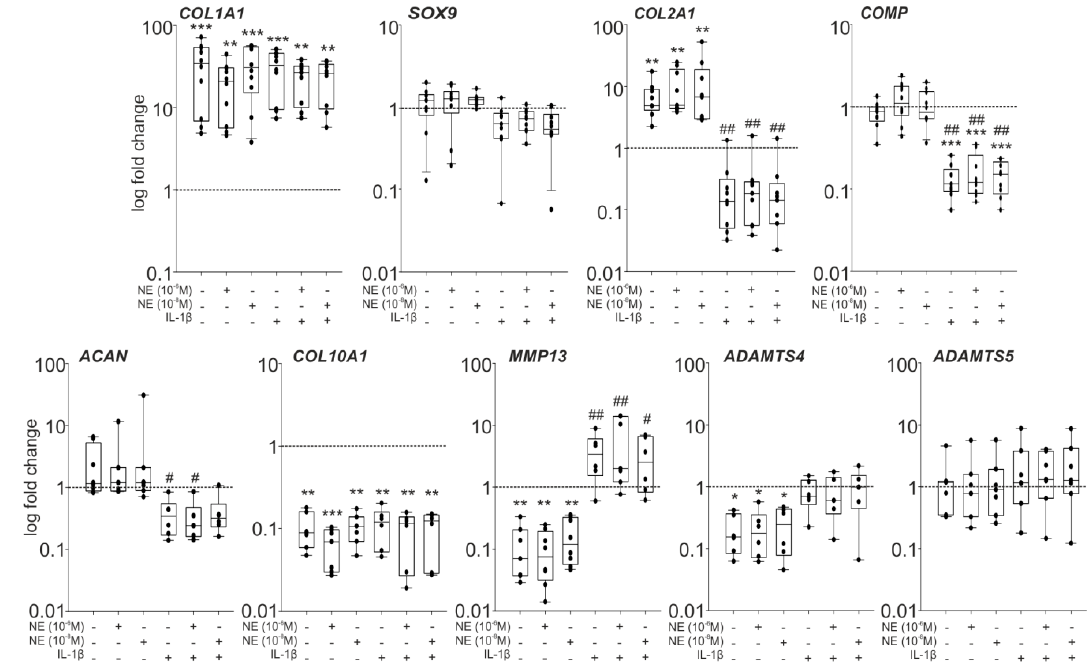
Figure 5. Effects of NE and IL-1 β on OA chondrocyte gene expression. Gene expression changes of the transcription factor SOX9, ECM components, and ECM-degrading enzymes after seven days in monolayer culture under NE and/or IL-1 β influence and physioxic conditions compared to day 0 (gene expression on day 0 = 1, represented by the dashed line). All experiments were carried out with cells from 8–10 patients, using duplicates for each patient. Each circle shows the mean of duplicates per patient. Box plots are explained in legend to Figure 1. Significant p -values against day 0 are presented as: * ( p ≤ 0.05), ** ( p ≤ 0.01), *** ( p ≤ 0.001). Significant p -values against untreated control are presented as: # ( p ≤ 0.05), ## ( p ≤ 0.01).